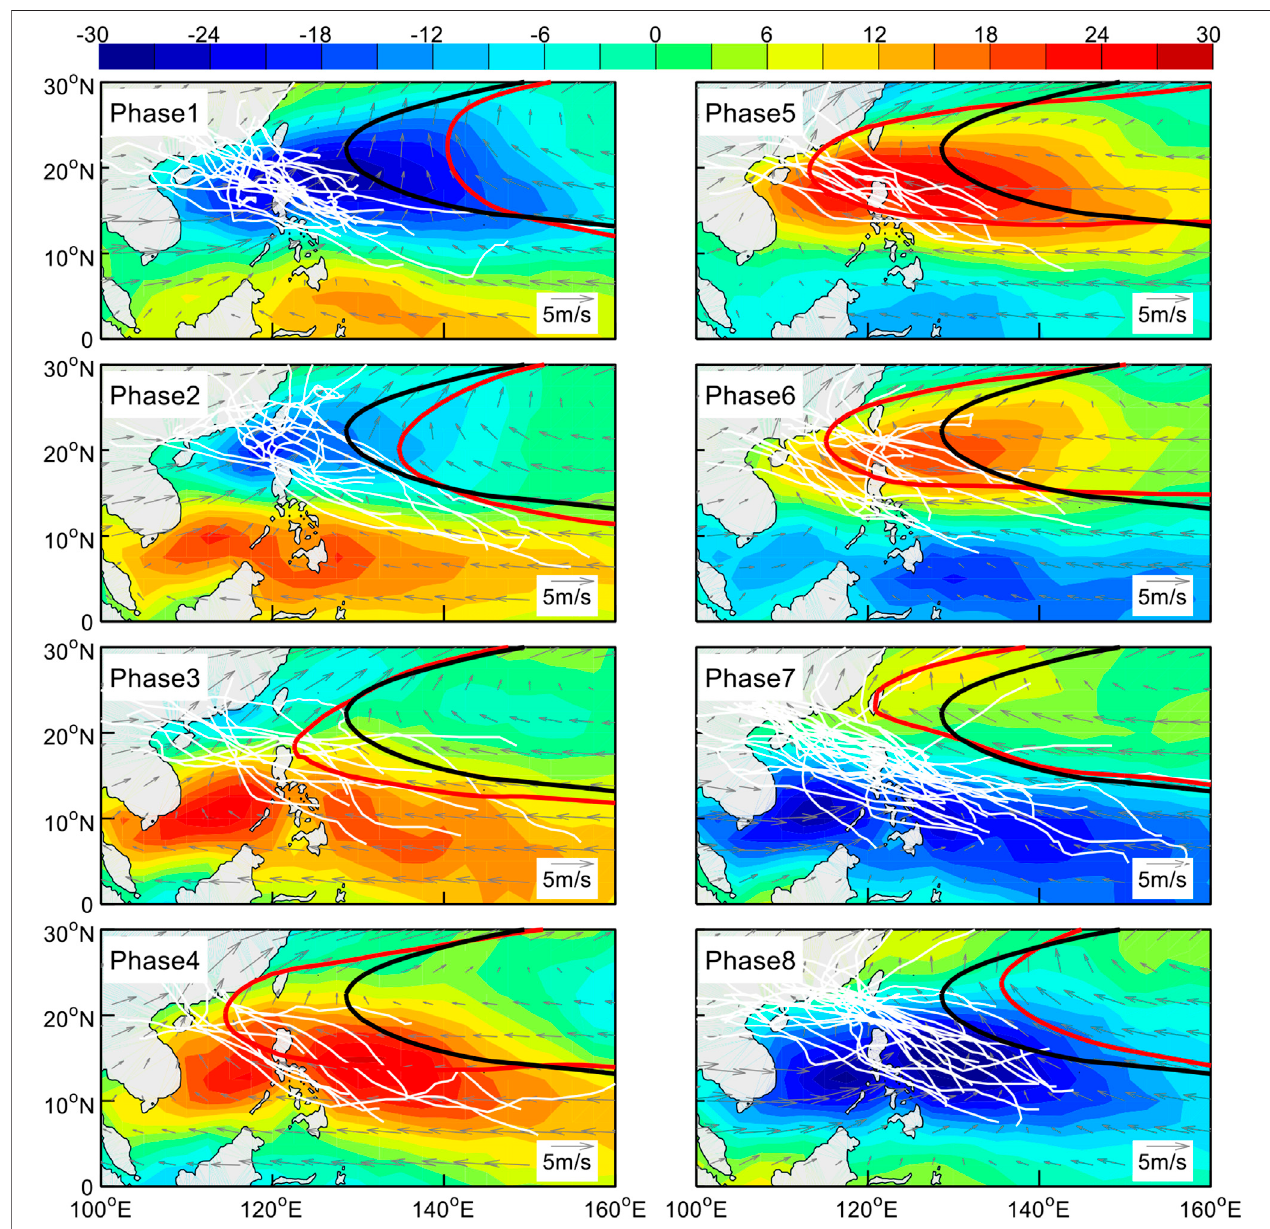
FIGURE 1 | The composite OLR anomalies (color, W m − 2 ), tracks of nonlocal TCs (white lines), the location of the western Paci fi c subtropical high and 300 – 850 hPamass-weighted steering fl ow(vectors, m s − 1 )ineach phase ofMJO.Blackcurves denotetheclimatological5,870geopotentialheightat 500 hPa,thered curves denote the 5,870 geopotential height over 500 hPa in each phase of MJO. The phase of the TC is based on the day that the nonlocal TCs enter the SCS.